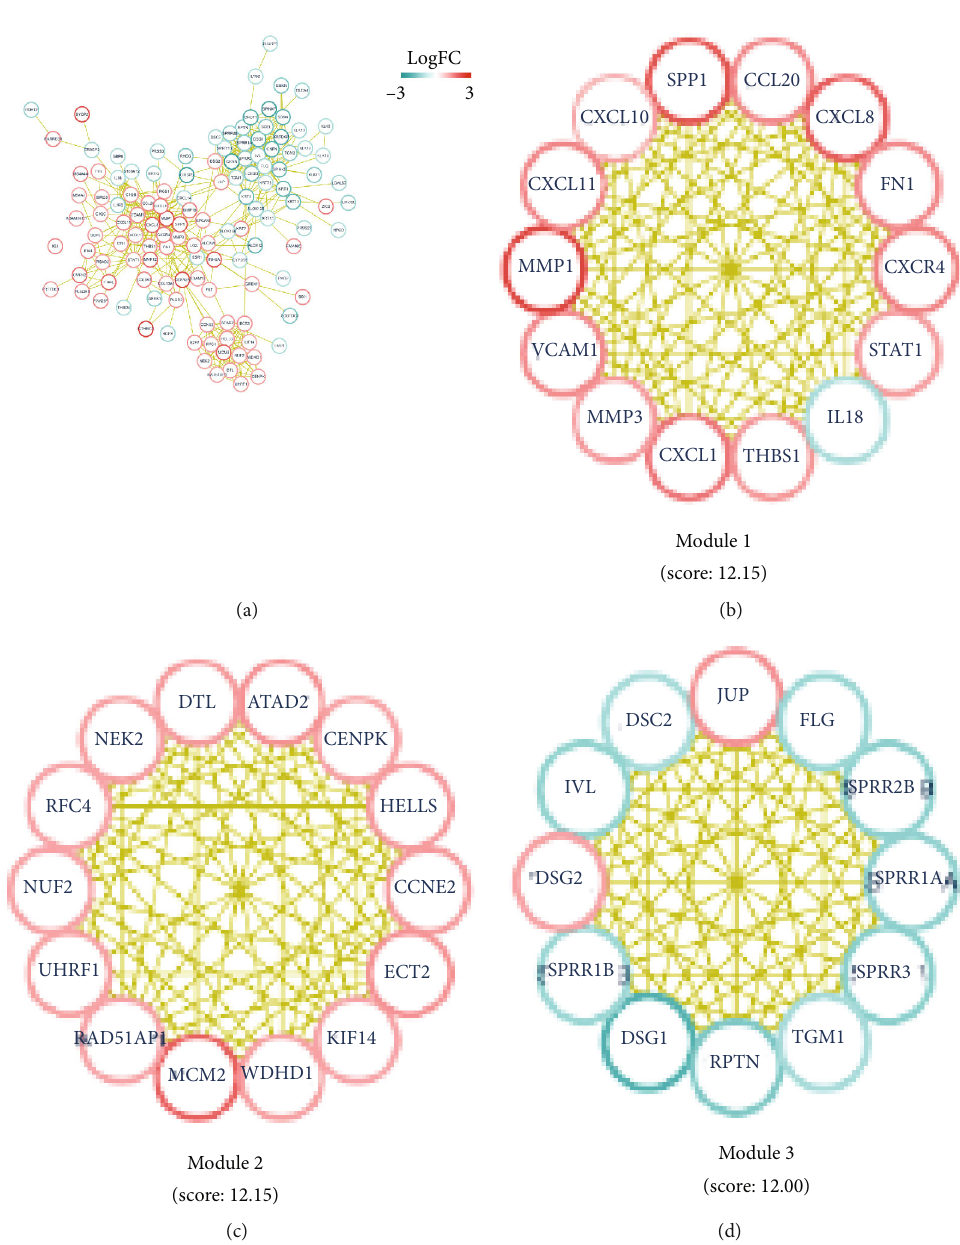
Figure 3: PPI network of DEGs in CC. (a) PPI network demonstrating the interactions between upregulated (red) and downregulated (green) proteins. (b) – (d) The three most signi fi cant submodules ( MCODEscores ≥ 10 ) contained 14 (b), 14 (c), and 12 (d) candidate DEGs, respectively. Node color is positively related to fold change in expression; yellow link indicates speci fi c or meaningful association among nodes. CC: cervical cancer; DEG: di ff erentially expressed gene; PPI: protein-protein